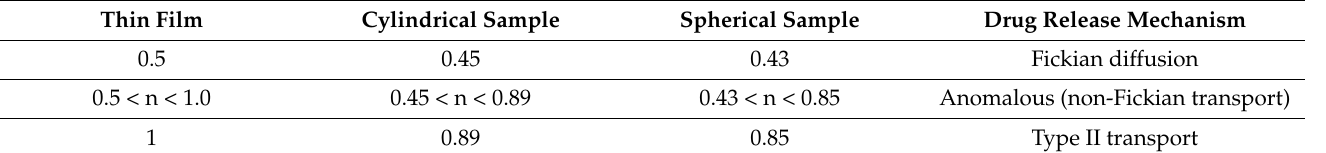
Table 2. Release exponent (n) in the Korsmeyer–Peppas and drug transport mechanisms